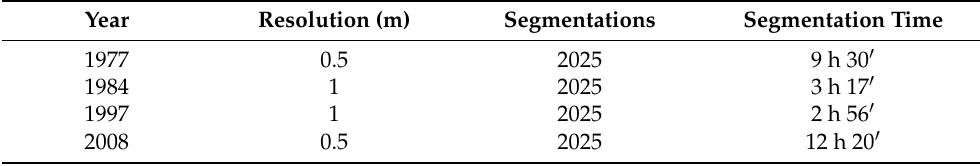
Table 3. Working times of the segmentation and validation of the